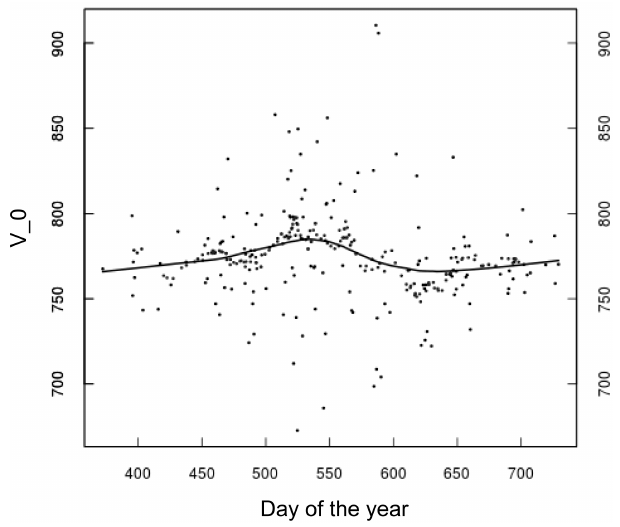
Figure 1. Calibration results for the 415nm channel from vis- MFRSR Langley plots. All V o s from the Langley plots are shown with dots. The loess estimate (black curve) is used for the assigned V o in the aerosol optical depth